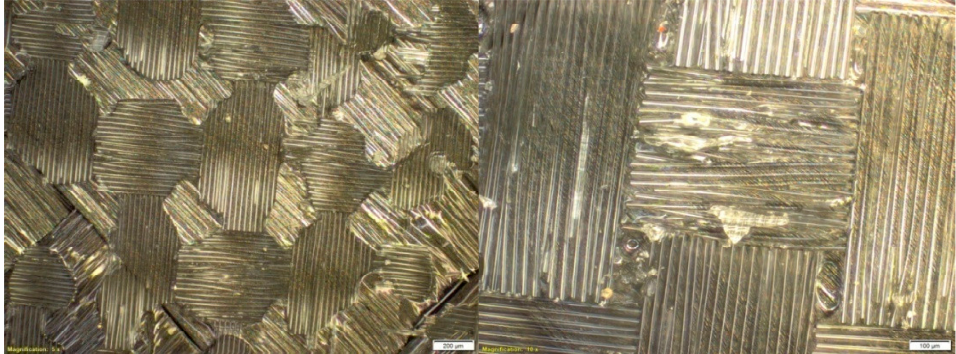
Figure 5. Microstructure of a composite laminate with the reinforcement of the symmetrical Inter- glas 02037 fabric [32]. 02037 fabric